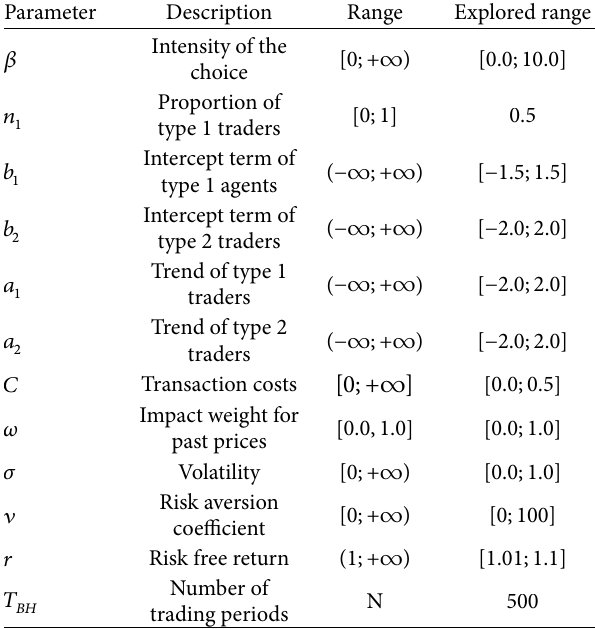
Table 1: Model parameters and range settings.